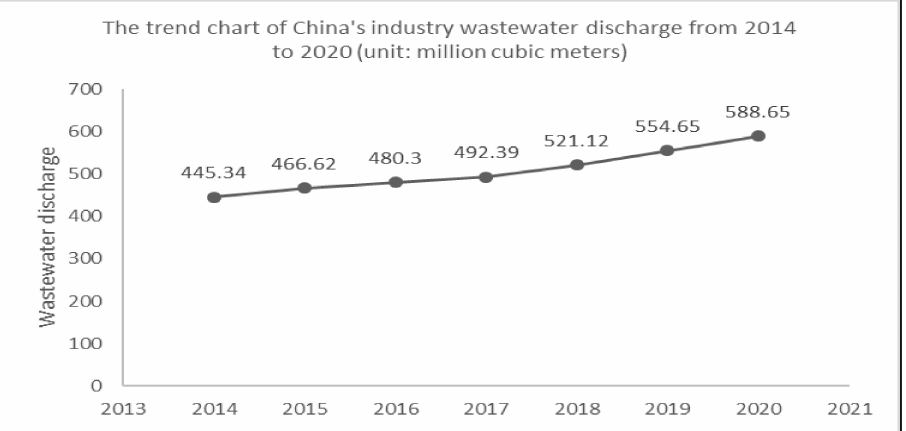
Figure 1. The trend chart of China’s industry wastewater discharge from 2014 to 2020 (unit: million cubic meters). Data sources: Statistical Yearbook of Urban